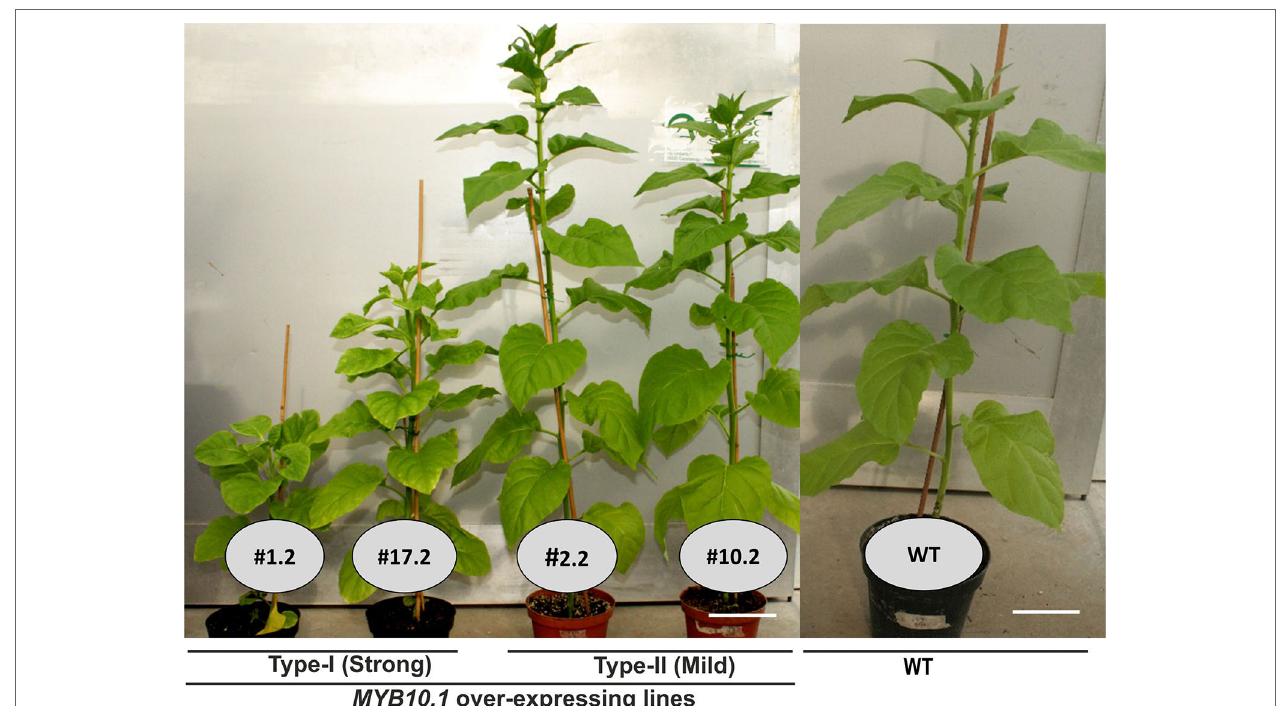
FIGURE 1 | Phenotypes of peach MYB10.1 overexpressing transgenic tobacco lines. Type I, strong phenotype (1.2 and 17.2); type II, mild phenotype (2.2 and 10.2); and WT, wild